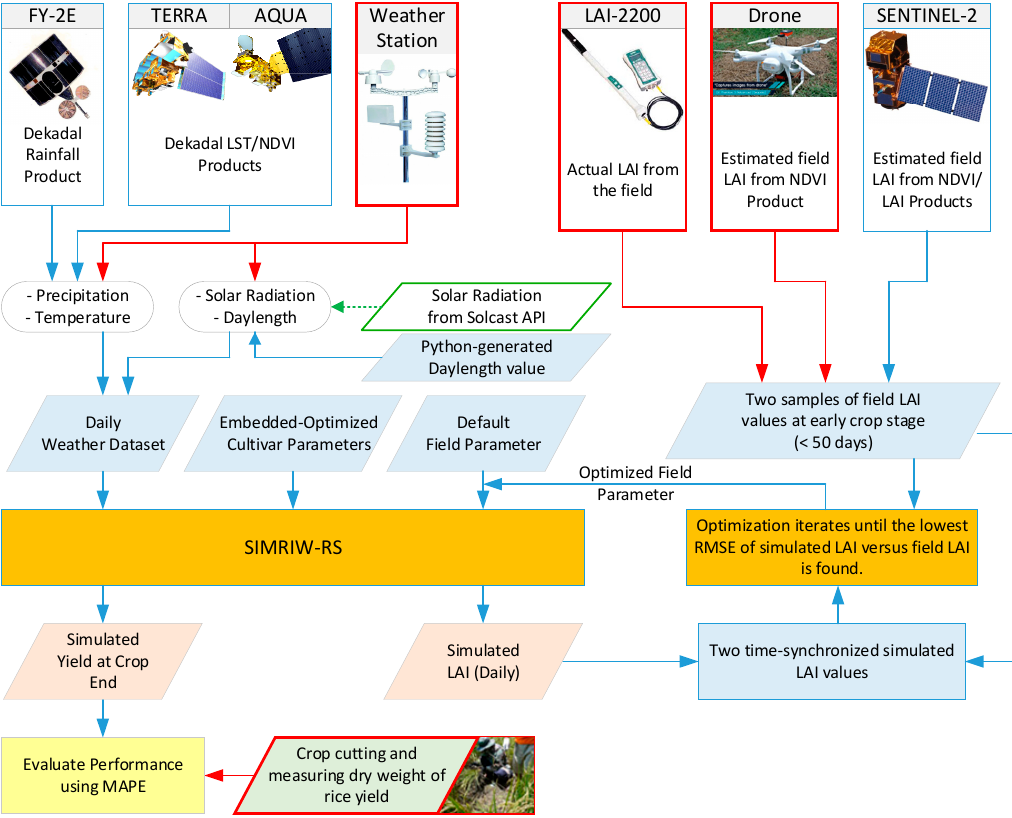
Figure 10. Proposed algorithm for the Simulation Model for Use with Remote Sensing—SIMRIW–RS recalibration. Red boxes represent data sources for recalibration and validation processes only, whereas green boxes represent future work. Only satellite products are required when operating SIMRIW–RS.